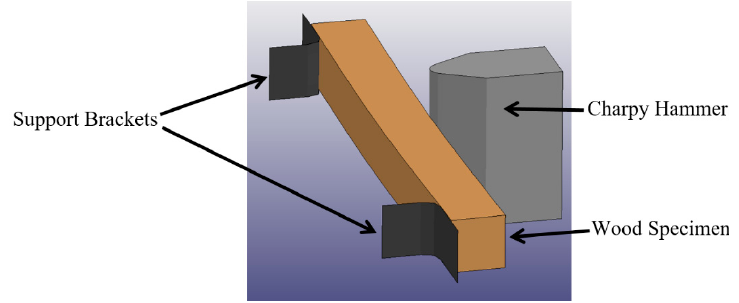
Figure 9. Charpy impact finite element model.